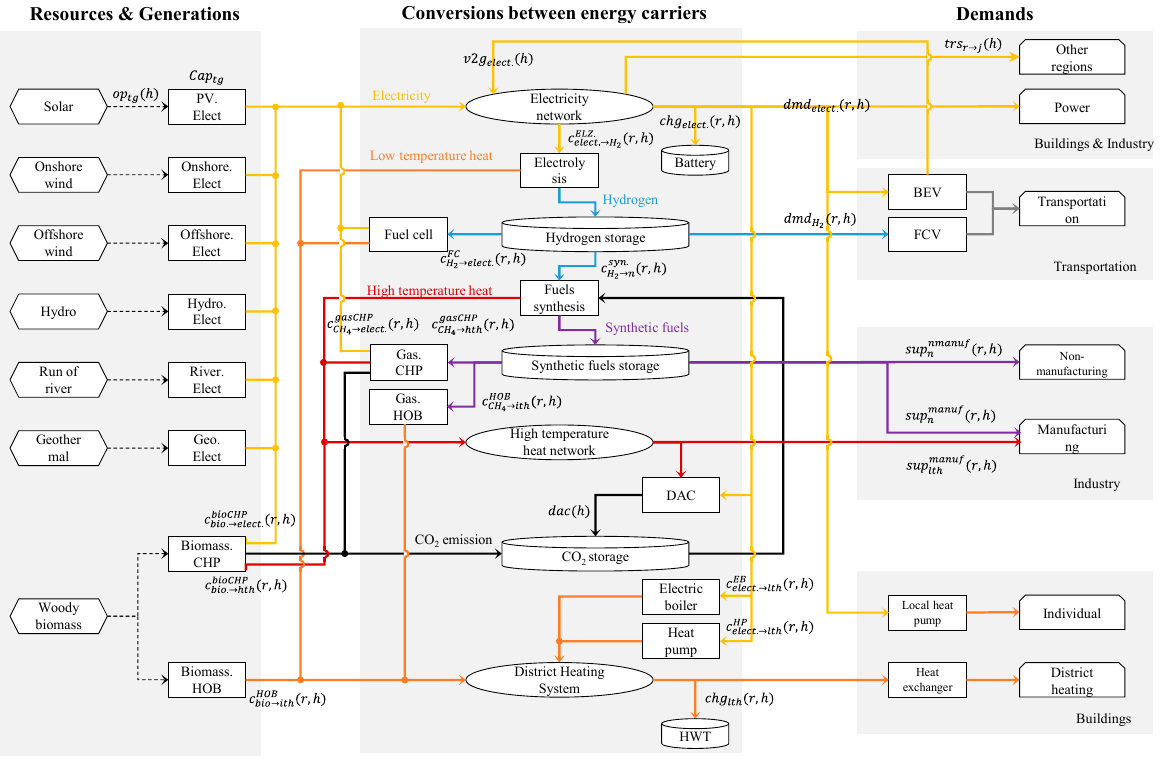
Figure 1. The system configuration of sector-coupled energy system designed in this study.